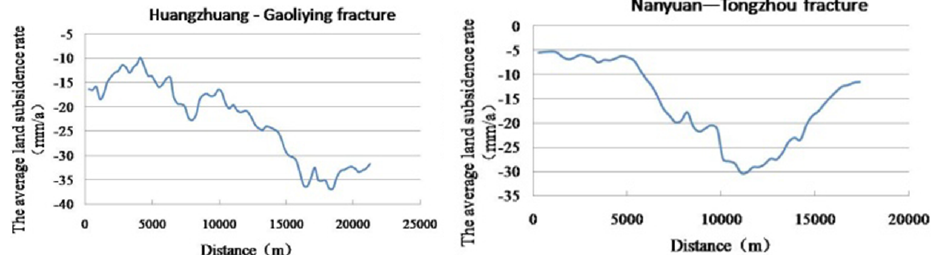
Figure 4. Deformation gradient map in two cross-sections at the Huangzhuang–Gaoliying fracture and Nanyuan–Tongzhou fracture.